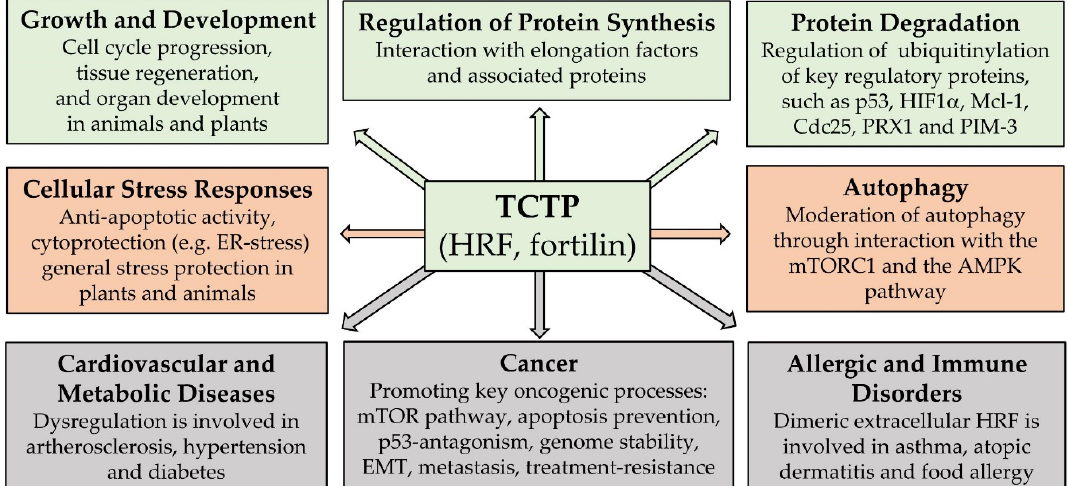
Figure 1. Schematic summary of core biological processes and of principal disease processes where TCTP is involved. (Green boxes: cell regulatory processes promoting growth and proliferation; orange boxes: cellular maintenance and defense systems; grey boxes: disease processes). This summary scheme is based on data compiled in the review articles [6,8,17], but also incorporates findings reported in some of the original articles of this Special Issue.